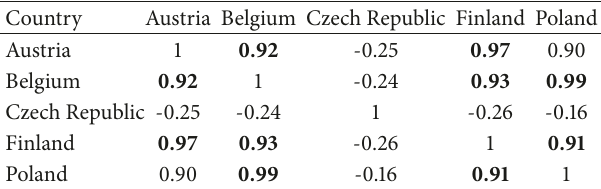
Table 2: Matrix of dependencies between selected countries.